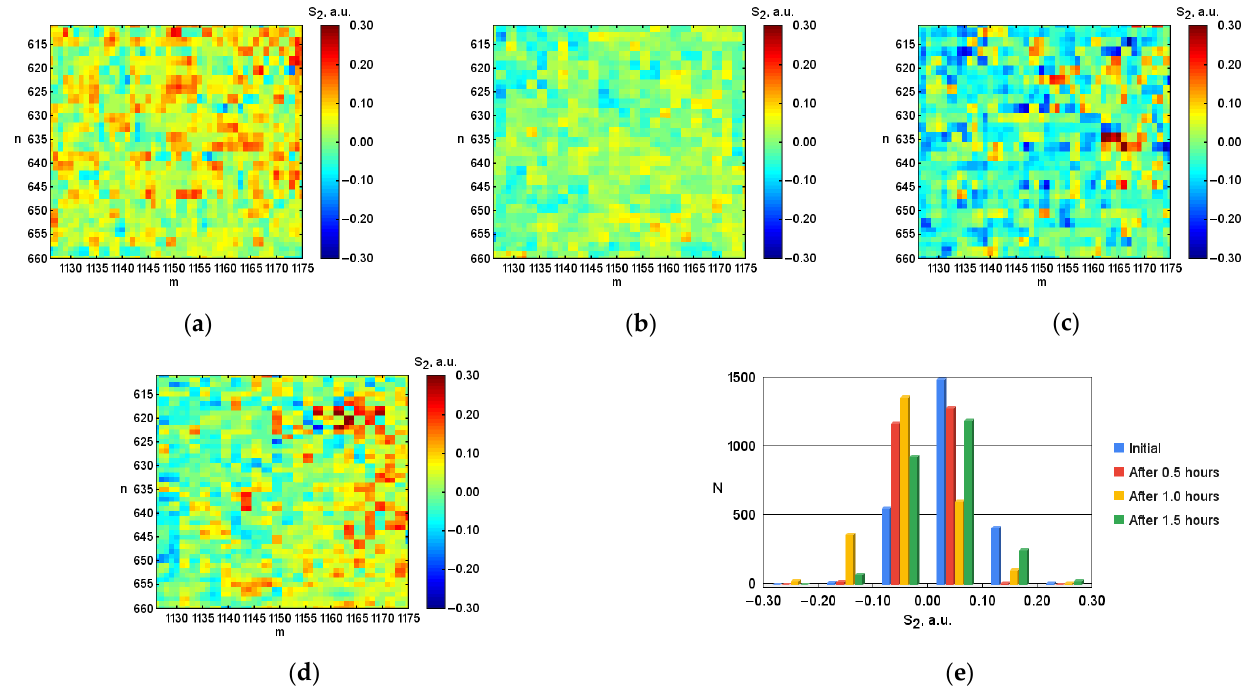
Figure 4. Coordinate distributions of the parameter of the Stokes vector S 2 , where: ( a ) is the initial hematocrit level; ( b ) is the hematocrit level after 0.5 h; ( c ) is after 1.0 h; ( d ) is after 1.5 h, and ( e ) the corresponding histograms of the object under investigation.